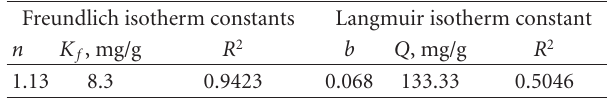
Table 4: Isotherm parameters for Cr(VI) biosorption by T. gamsii biomass at various dilutions of electroplating industrial